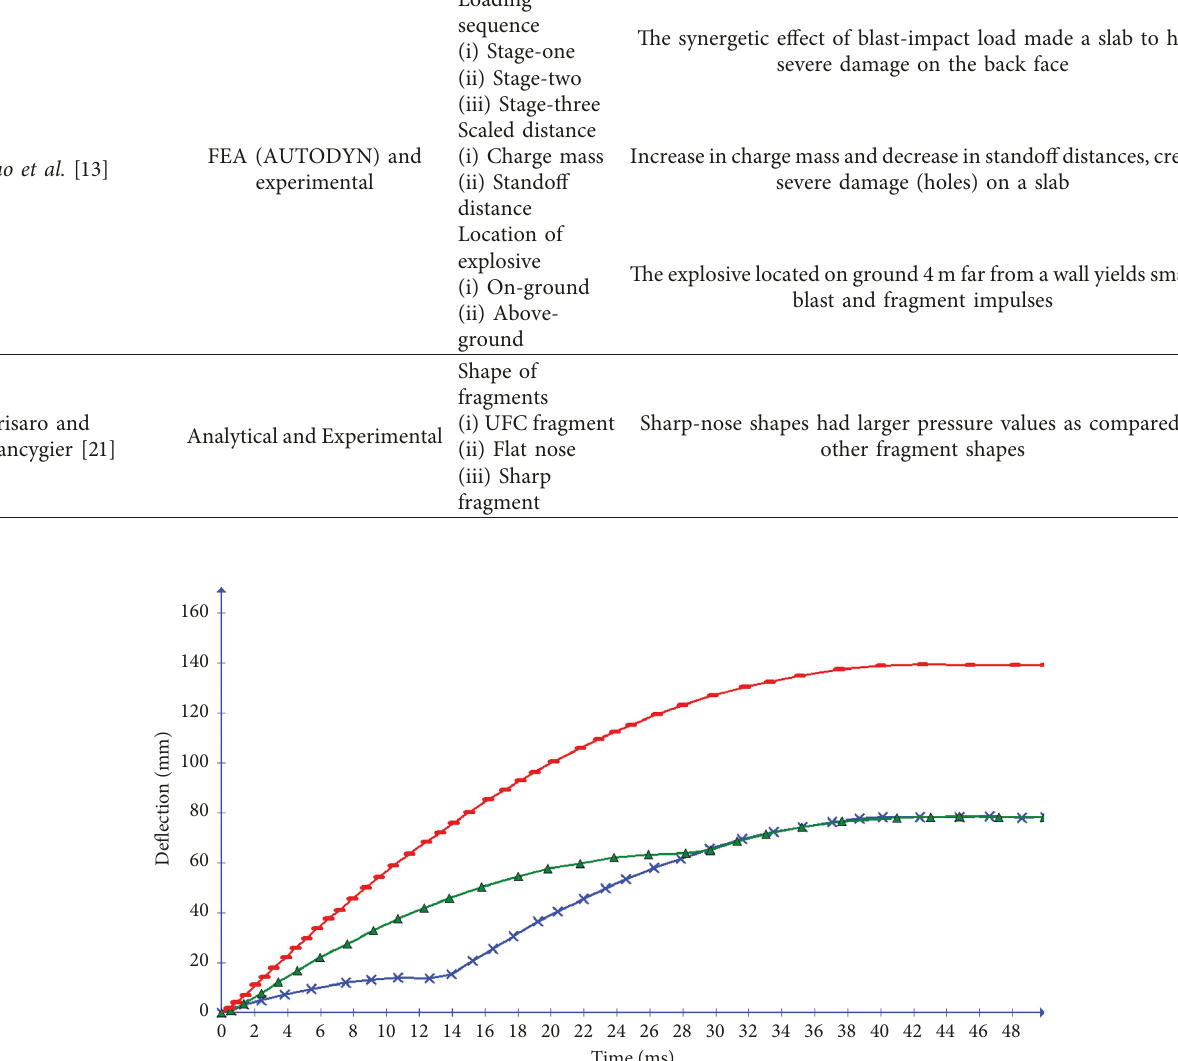
Table 7: Summary of different parameters and respective effects on slab panels subjected to combined blast and fragment impact loads. Author